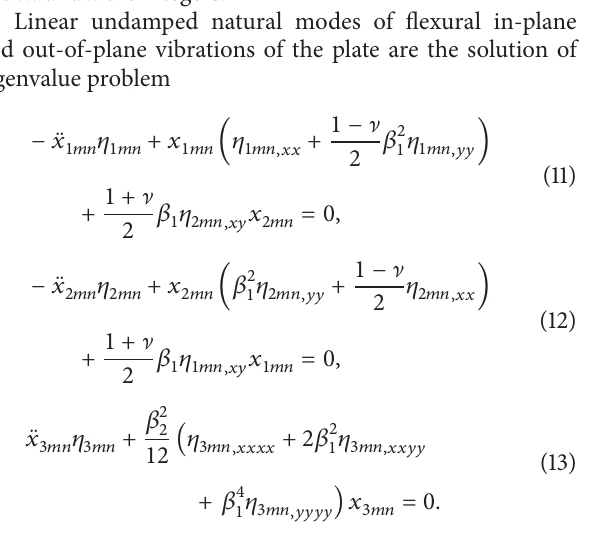
where dimensional values are marked by asterisks, and 𝐸 is the Young modulus of the plate